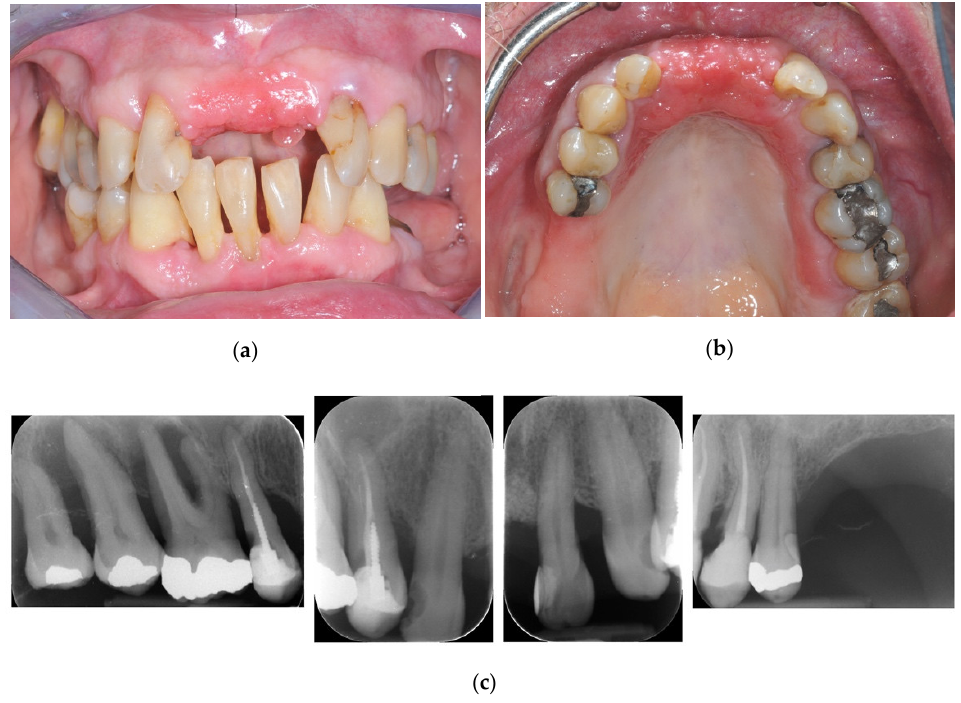
Figure 1. Baseline clinical situation: ( a ) the frontal view is represented, ( b ) the occlusal view of the maxillary arch and ( c ) the radiographic assessment of the case.